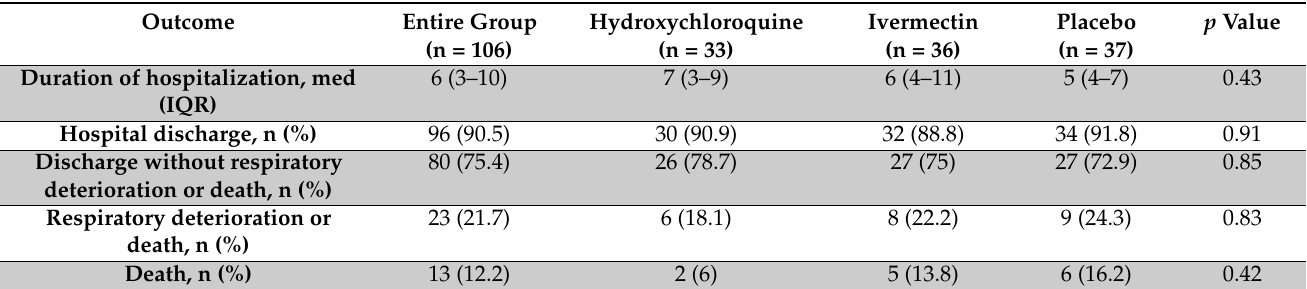
Table 6. Outcomes. IQR: interquartile range.